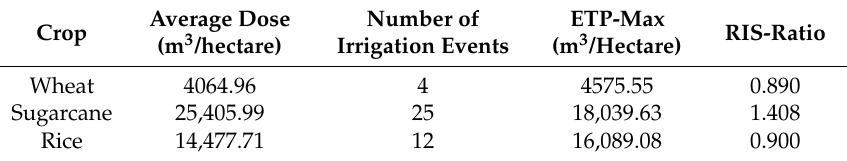
Table 3. Irrigation water supply and relative use by crops in Rakh Branch